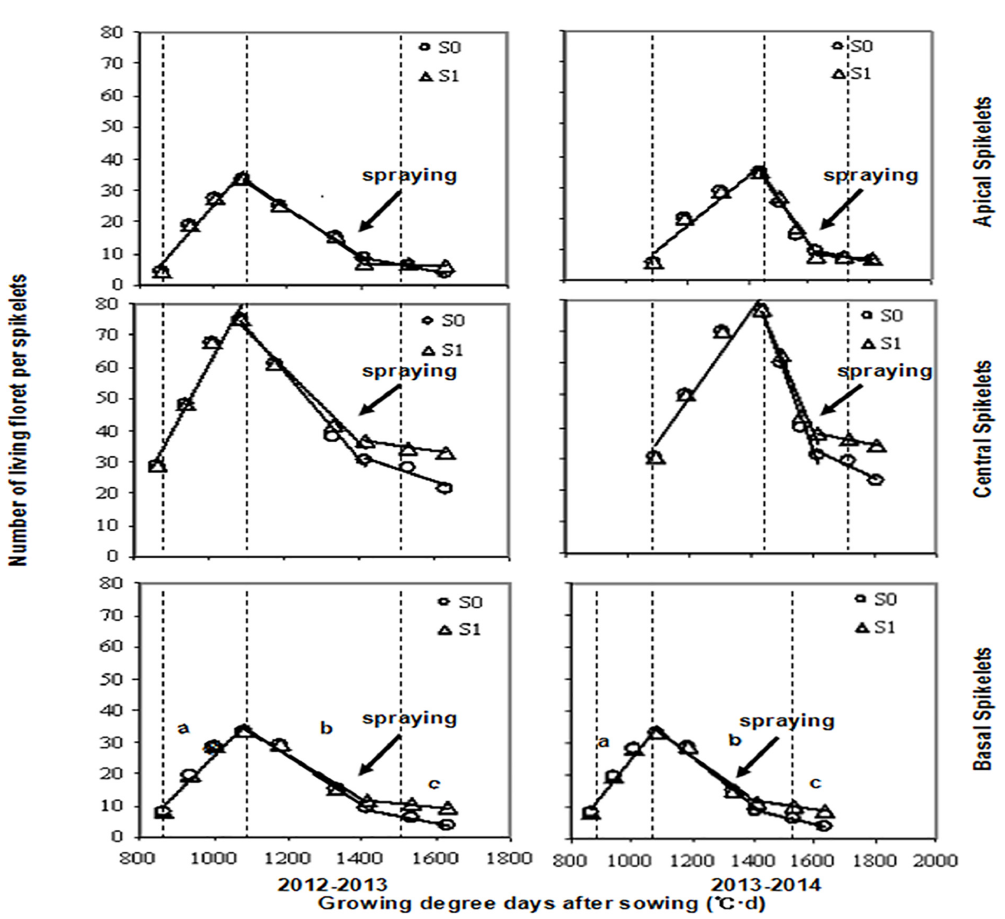
Fig 3. Dynamics of floret primordia from jointing to five days after anthesis in winter wheat in response to two foliar spray treatments (S0: water [circles]; S1: 6-BA [triangles]) in three spikelet categories (basal, central and apical). The lowercase letters indicate the three stages of floret developmental dynamics: differentiation (a), degeneration (b) and abortion (c). In each panel, the left dotted lines indicate jointing, the middle dotted lines indicate 21 days after jointing, and the right dotted lines indicate flowering. The arrows indicate the point at which spraying was